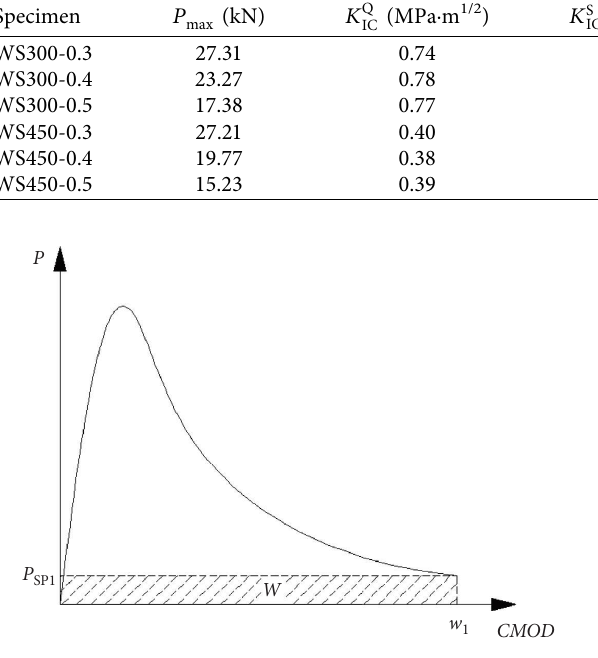
Figure 5: Te determination method of tail fracture